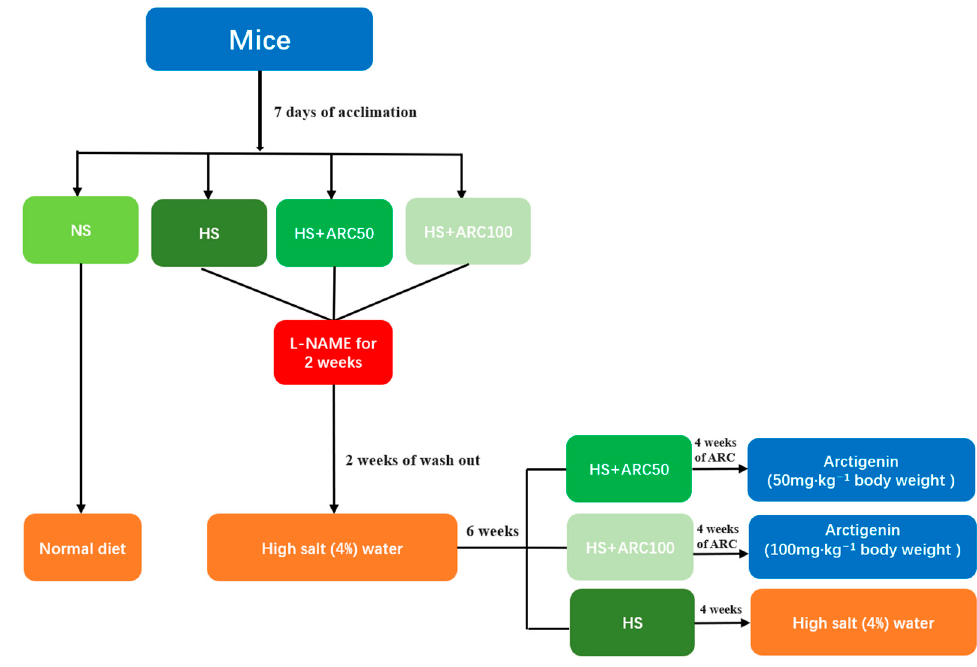
Figure 1. Flow chart of animal model.